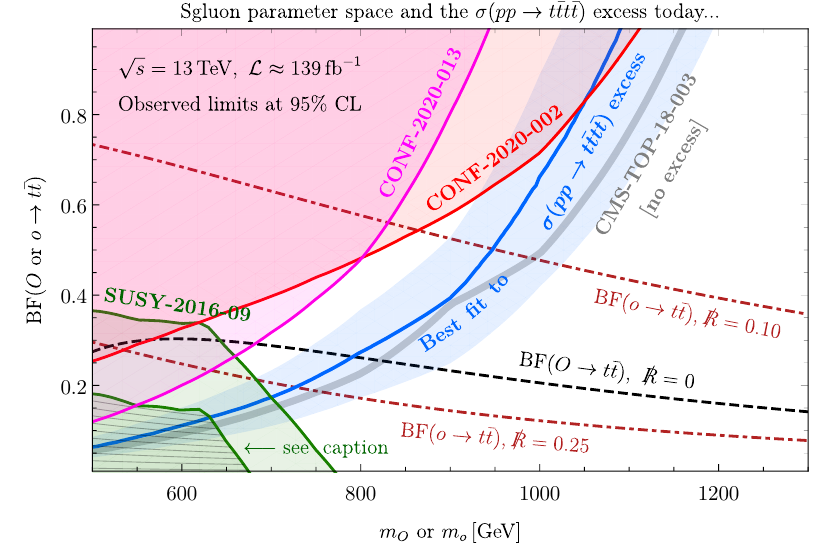
Figure 9 . Expanded map of color-octet scalar parameter space, including regions excluded by relevant analyses and favored by the excess in σ ( pp → t ¯ tt ¯ t ) reported by ATLAS. This and subsequent plots are in a generic plane of color-octet scalar mass and branching fraction to top quarks. Dashed lines trace branching fractions to t ¯ t for indicated sgluon in specific scenarios described in text. Larger green region applies to pseudoscalar, which has no decays involving an electroweak gauge boson. Smaller hatched green region (visible also in figure 8) applies to scalar, which does enjoy such decays, thus weakening its branching fraction to gluons. Limits from most recent CMS measurement finding no excess are again displayed for context. See figure 10 for HL-LHC projections in the same parameter